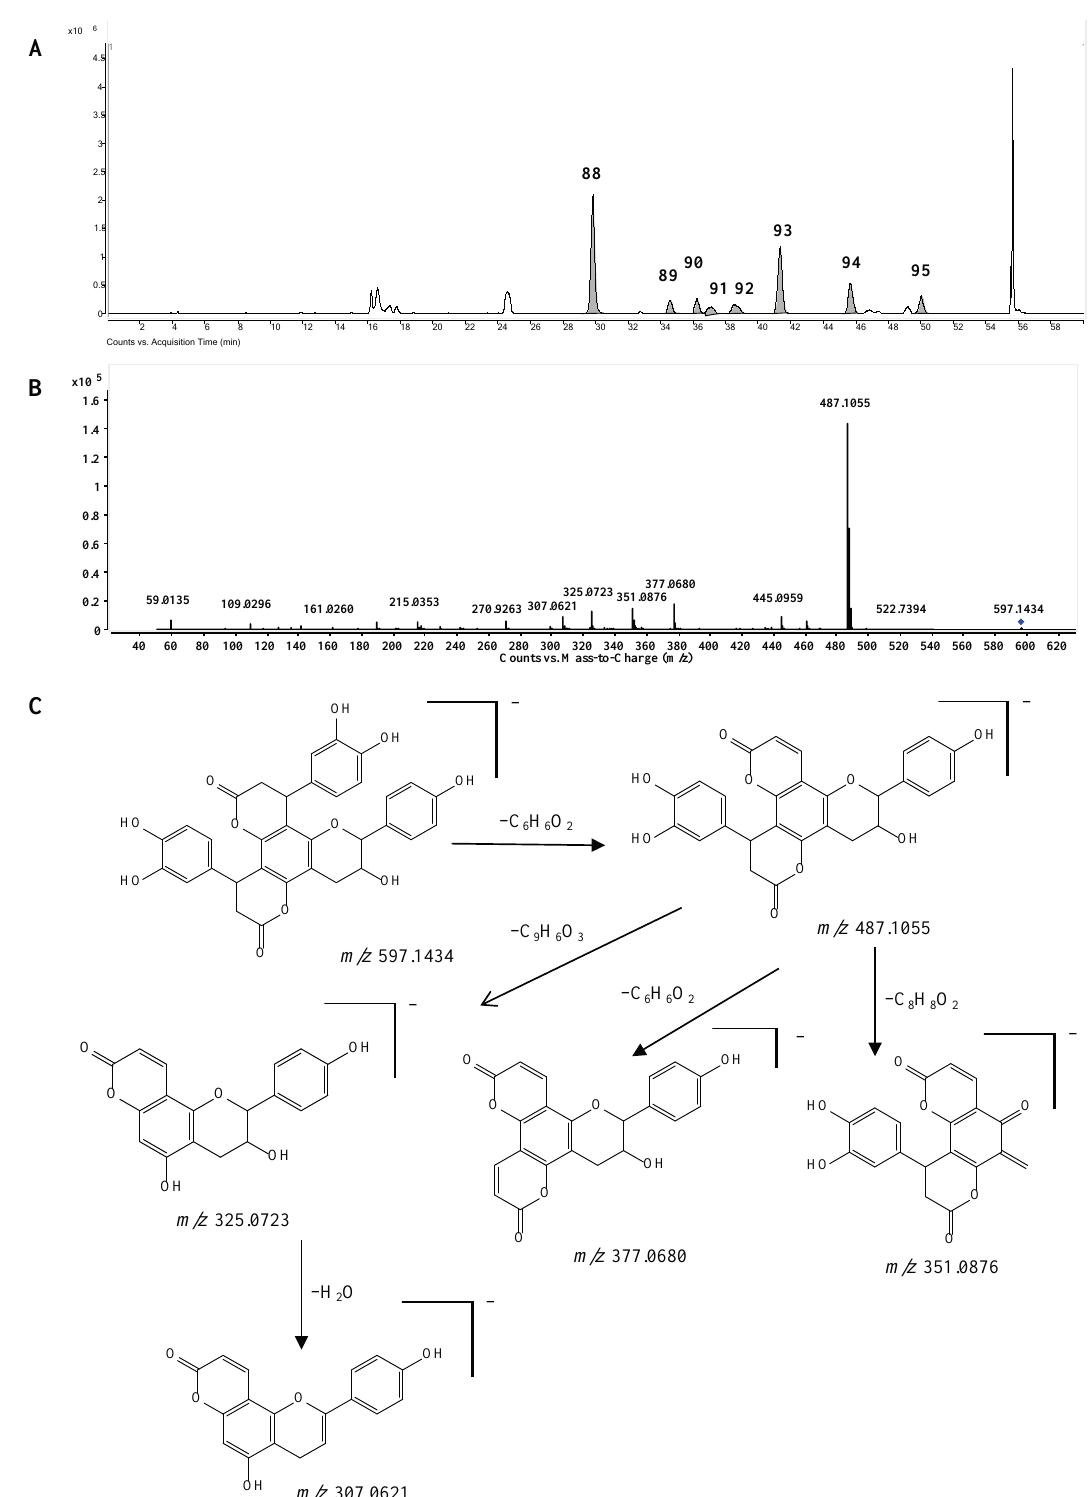
Figure 7. ( A ) Extracted ion chromatogram (EIC) of compounds 88 – 95 ; ( B ) MS/MS spectrum of compound 88 ; ( C ) Proposed fragmentation pathway of compound 88